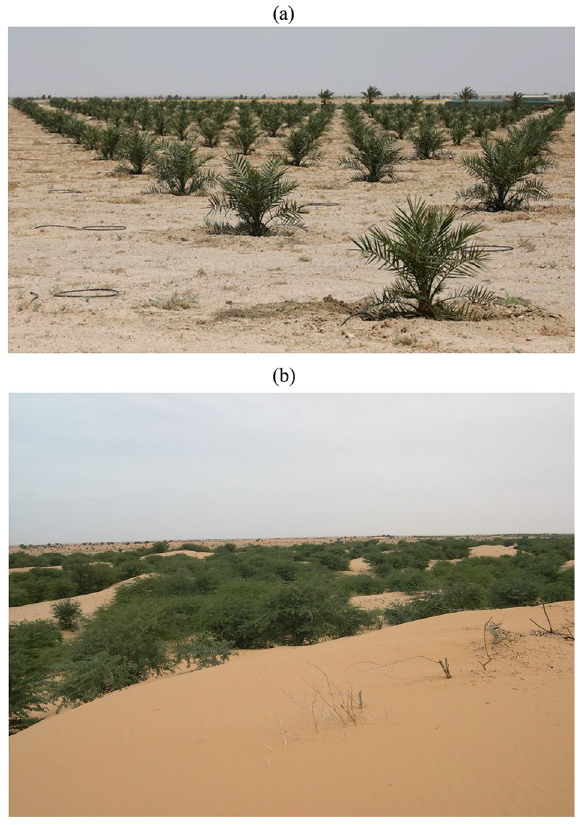
Figure 1. Fighting desertification: ( a ) Anti-sand shields in Iraq, south of Baghdad, ( b ) “Greenbelt” of Nouakchott,